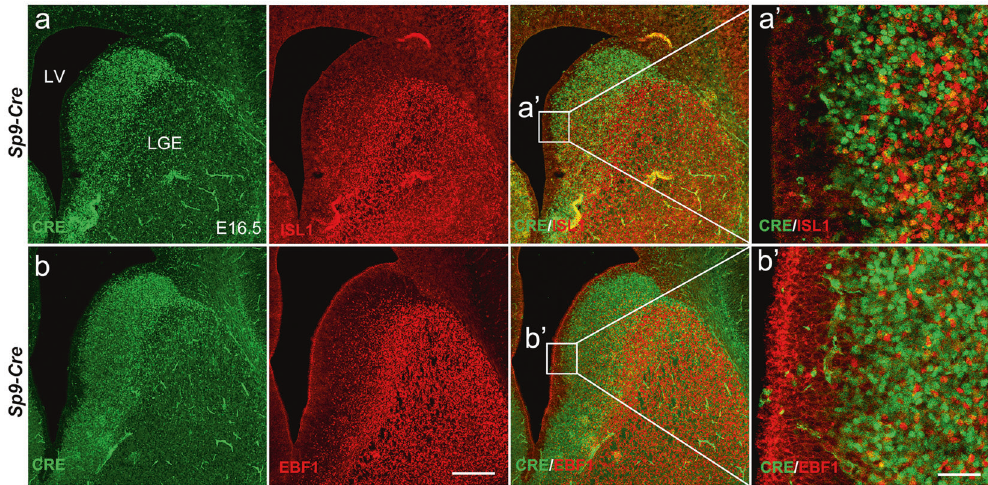
Fig. 4 SP9 expression is downregulated in immature postmitotic D1-MSNs. a ISL1 + /CRE + double immunostaining in Sp9-Cre LGE at E16.5. a ’ Higher magni fi cation images of the ISL1 + /CRE + cells in the LGE. b EBF1 + /CRE + double immunostaining in the Sp9-Cre LGE at E16.5. b ’ Higher magni fi cation images of EBF1 + /CRE + cells in the LGE. Notably, nearly all ISL1 + or EBF1 + cells fail to be co-labeled with CRE ( a ’ and b ’ ). Scale bars: 200 µm in b for a – b , and 50 µm in b ’ for a ’ – b ’